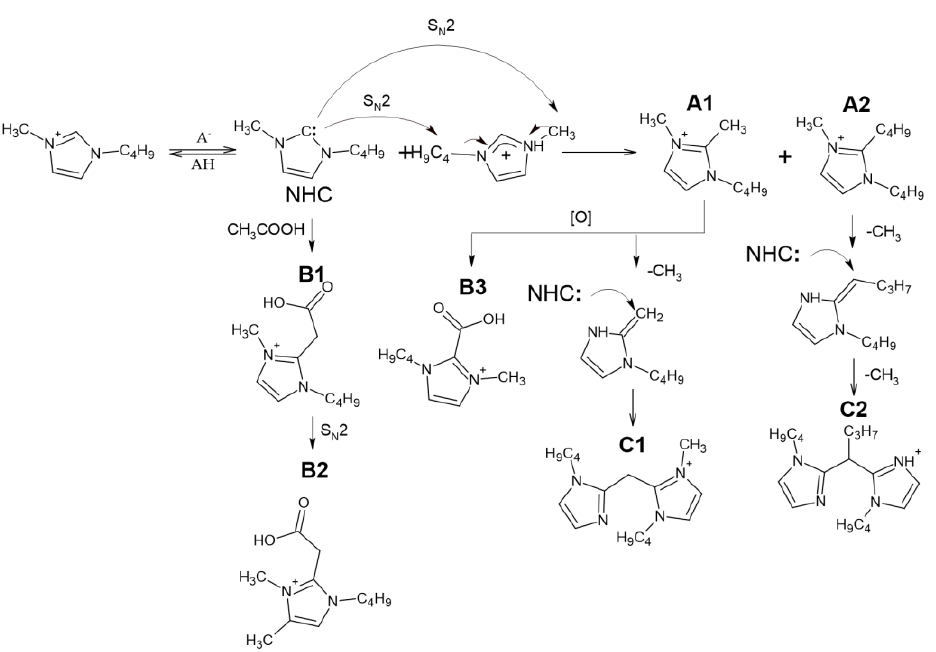
Figure 3. Assumed bmim degradation pathways leading to formation of less volatile products.